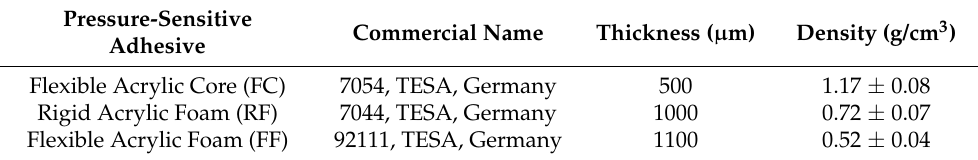
Figure 1. Aluminium joint assembled with the pressure-sensitive adhesive. Table 2. Type and thickness of the adhesives.